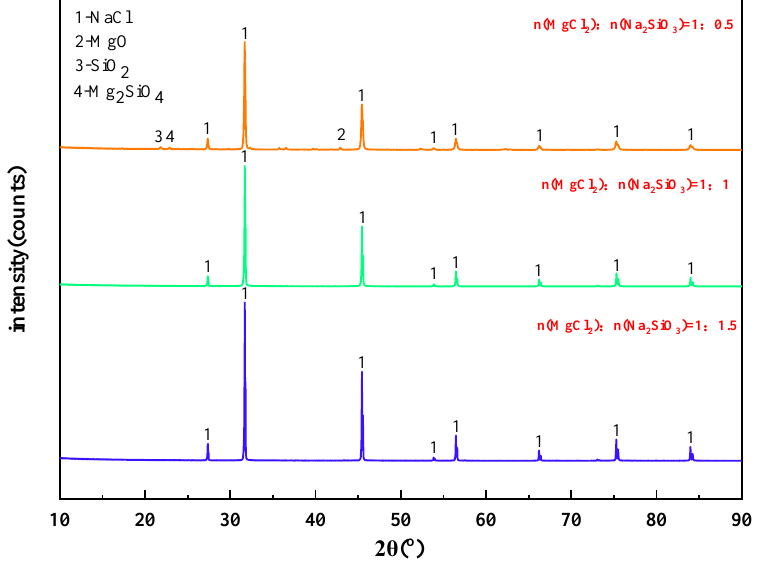
Figure 8. XRD of filtrate obtained with different dosage of additives.